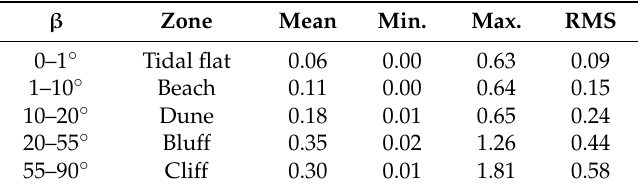
Table 2. LiDAR vertical accuracy assessments as function of cliff slope [11].